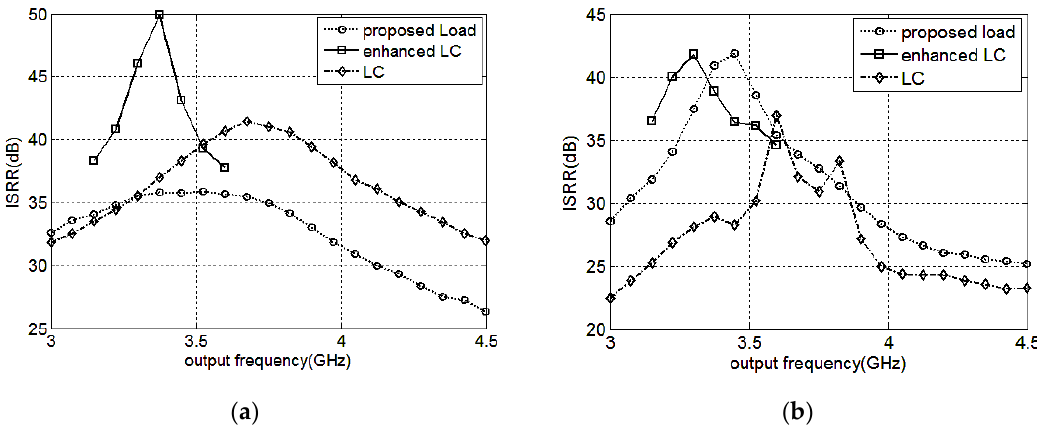
Figure 11. The image side-band rejection ratio (ISRR) versus the operating range at the mixer outputs ( a ); and buffer outputs ( b ).